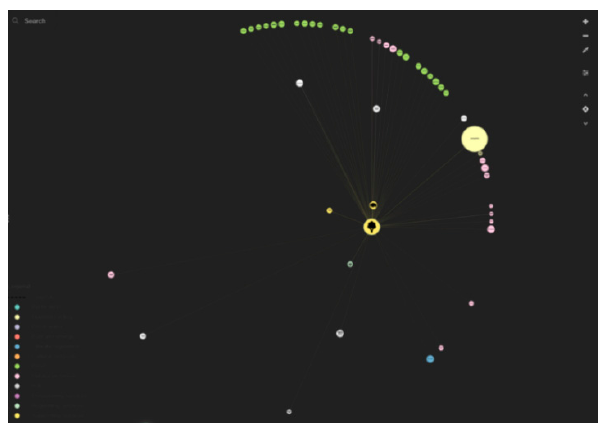
Figure 3. Schematic visualization of inner-circle, or inter-circle relationships line connections (1–9) identified between elements (ecosystem services, subcategories, design strategies, and case studies).